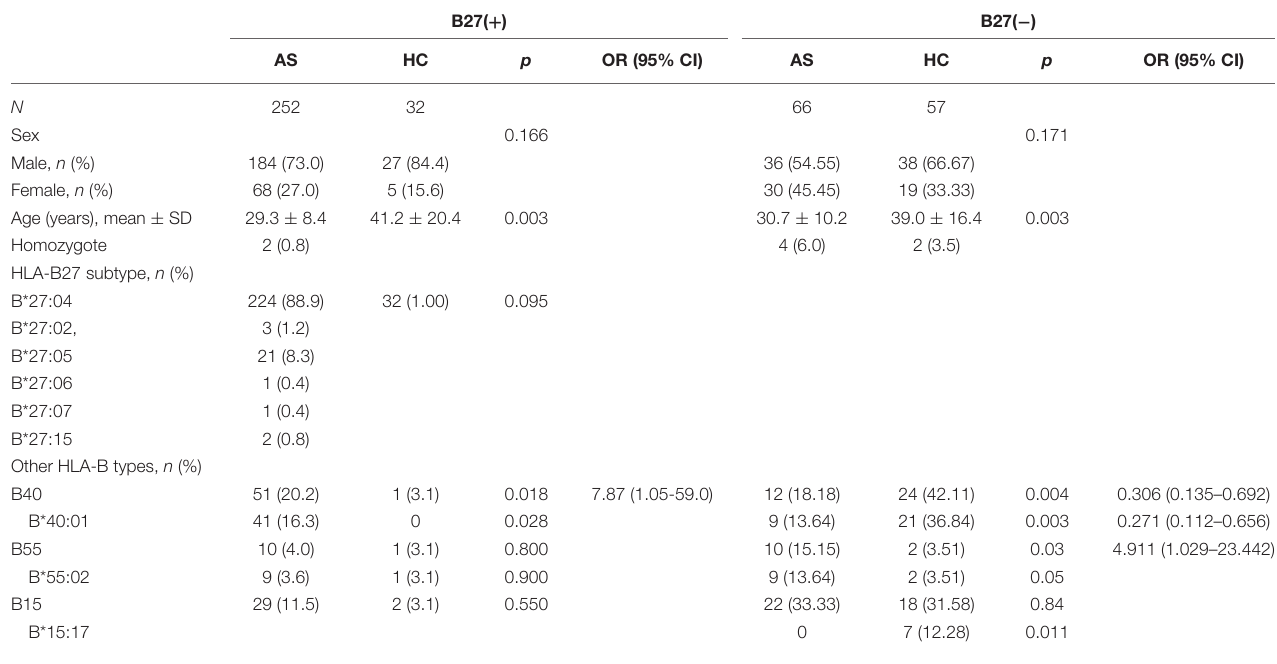
FIGURE 2 | The HLA-B type distribution in HLA-B27( + ) and HLA-B27( − ) group: (A) HLA-B type distribution in HLA-B27( + ) patients and HLA-B27( + ) controls, and (B) HLA-B type distribution in HLA-B27( − ) patients and HLA-B ( − ) controls. Chi-squared test were used to determine significance (* p < 0.05). AS, ankylosing spondylitis; HC, health control. TABLE 2 | The HLA-B27 subtypes in all B27( + ) groups and the associated HLA-B types in B27( + ) and B27( − ) groups (step